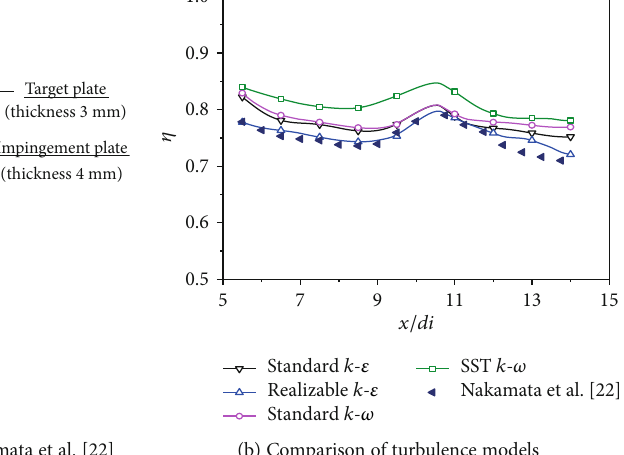
Figure 4: Test of turbulence